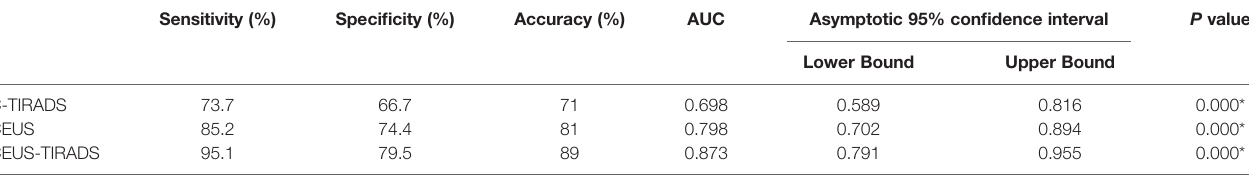
TABLE 5 | Diagnosis performance of C-TIRADS, CEUS and CEUS-TIRADS diagnostic model in validation